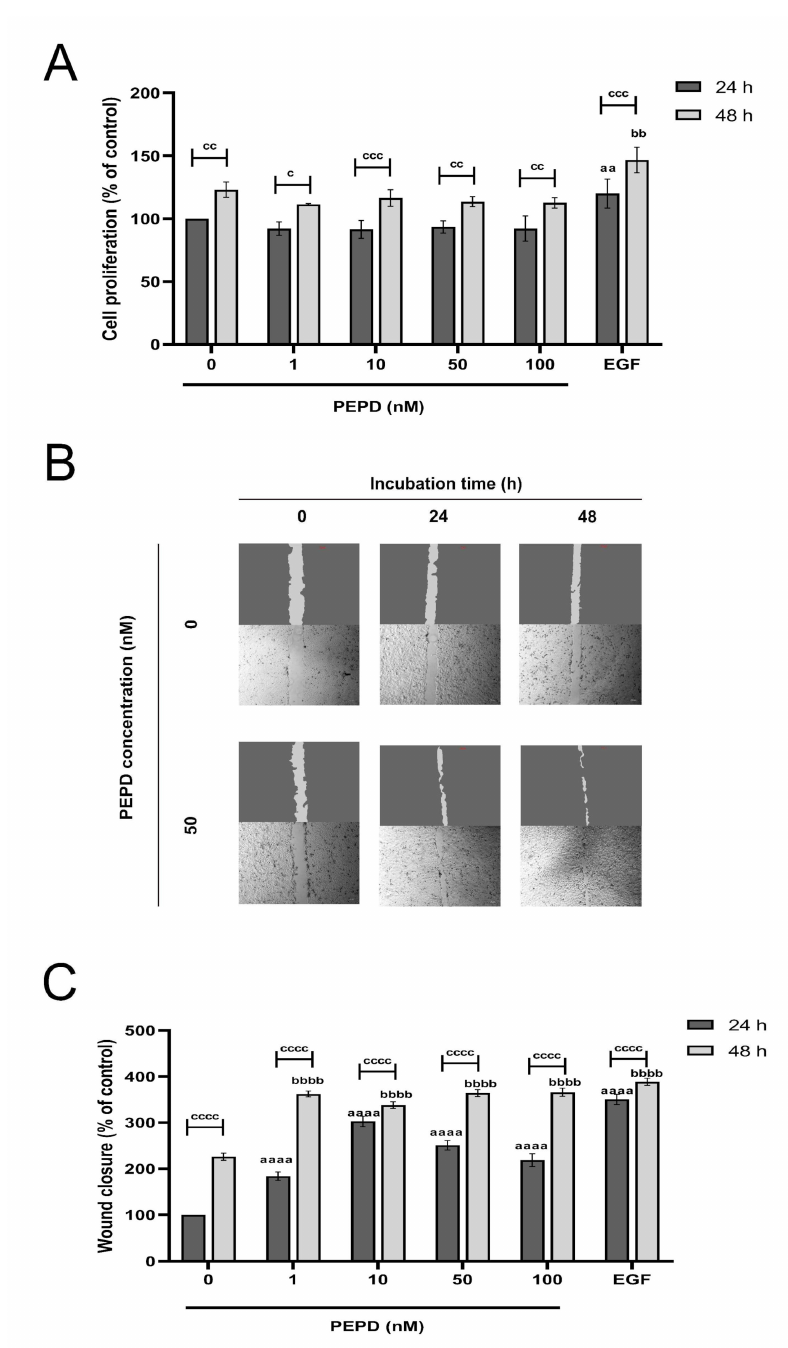
Figure 1. Prolidase promotes proliferation and migration of HaCaT cell lines. ( A ) Cell proliferation was evaluated by CyQuant Proliferation assay after 24 and 48 h upon prolidase supplementation. ( B ) Microscopic images of wound closure in scratched assay monitored using an inverted microscope (40 × magnification) after 24 and 48 h incubation with prolidase (50 nM) compared to control cells. Supplementary Materials contain microscopic images in triplicates (Supplementary Figure S1). ( C ) The wound closure rate was evaluated by ImageJ software in HaCaT cells treated for 24 and 48 h with prolidase at concentrations of 1–100 nM. EGF was used as a positive control. A mean ± SEM of three replicates is presented. The results are significant at c < 0.05, aa , bb , or cc < 0.01, ccc < 0.001, and aaaa , bbbb , or cccc < 0.0001 and are marked as a vs. control (0 nM of PEPD) of 24 h incubation, b vs. control (0 nM of PEPD) of 48 h incubation, and c marked 24 h incubation cells vs. 48 h incubation cells at the same concentration of PEPD or EGF,